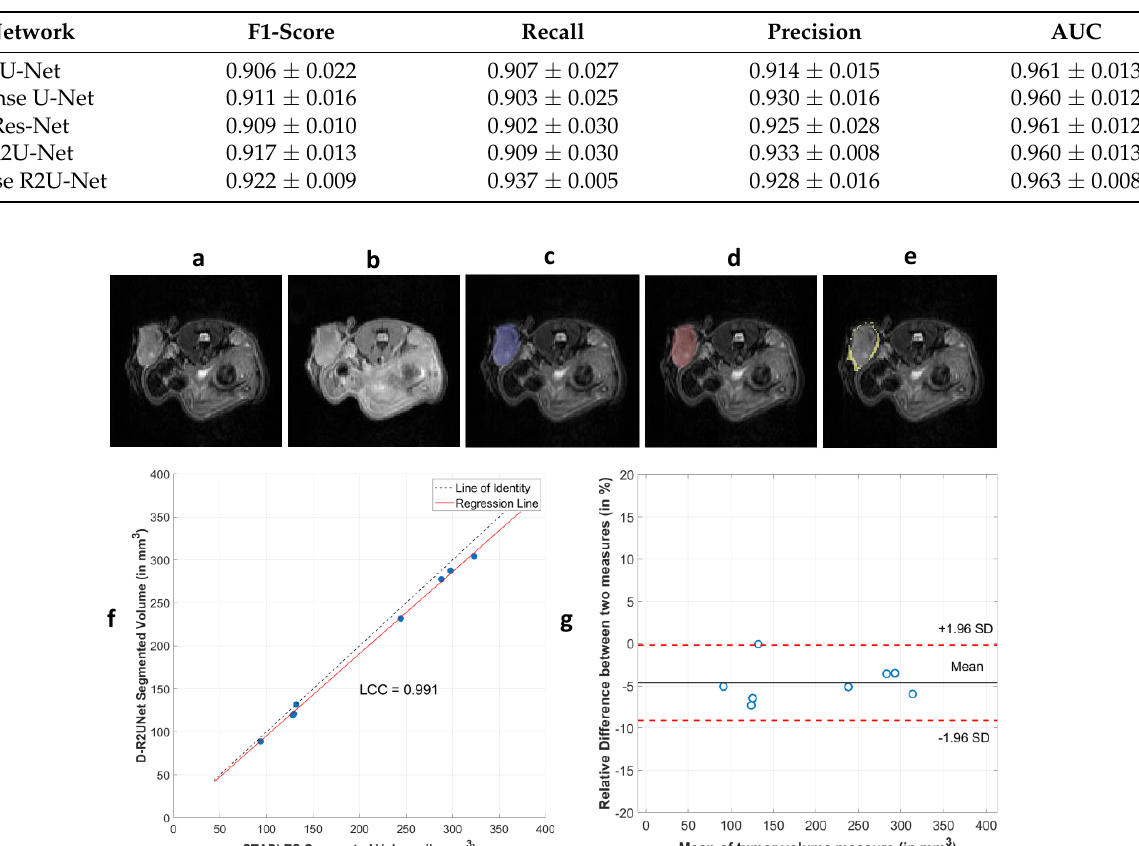
Table 3. Performance metrics (mean ± SD) of fivefold cross-validation for the different network models.